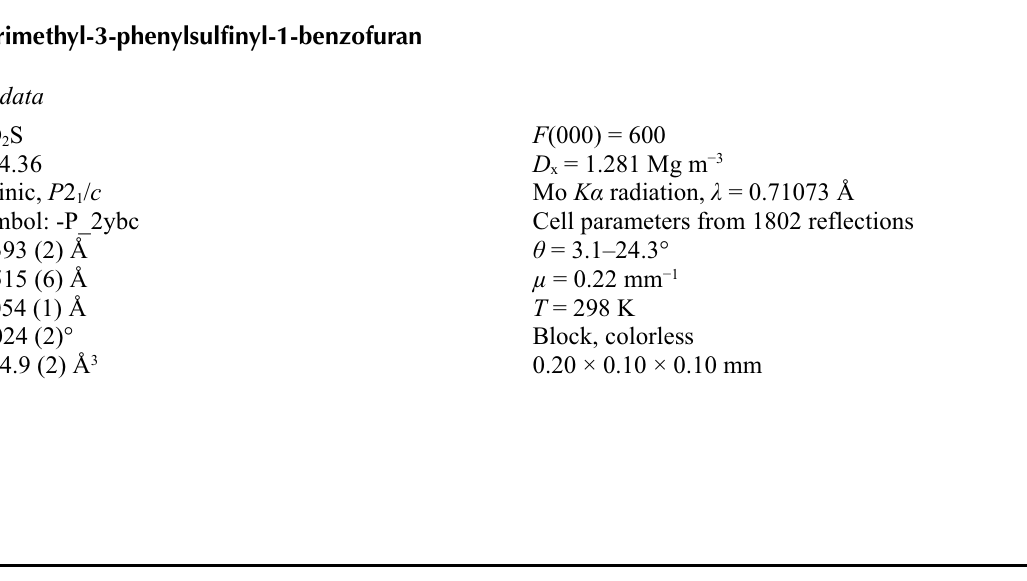
The molecular structure of the title compound, showing displacement ellipsoides drawn at the 30% probability level.